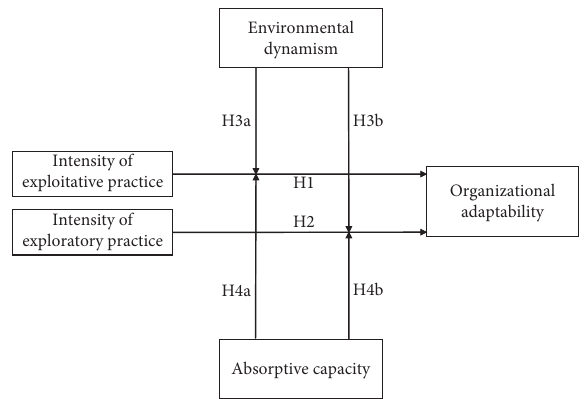
Figure 1: Research